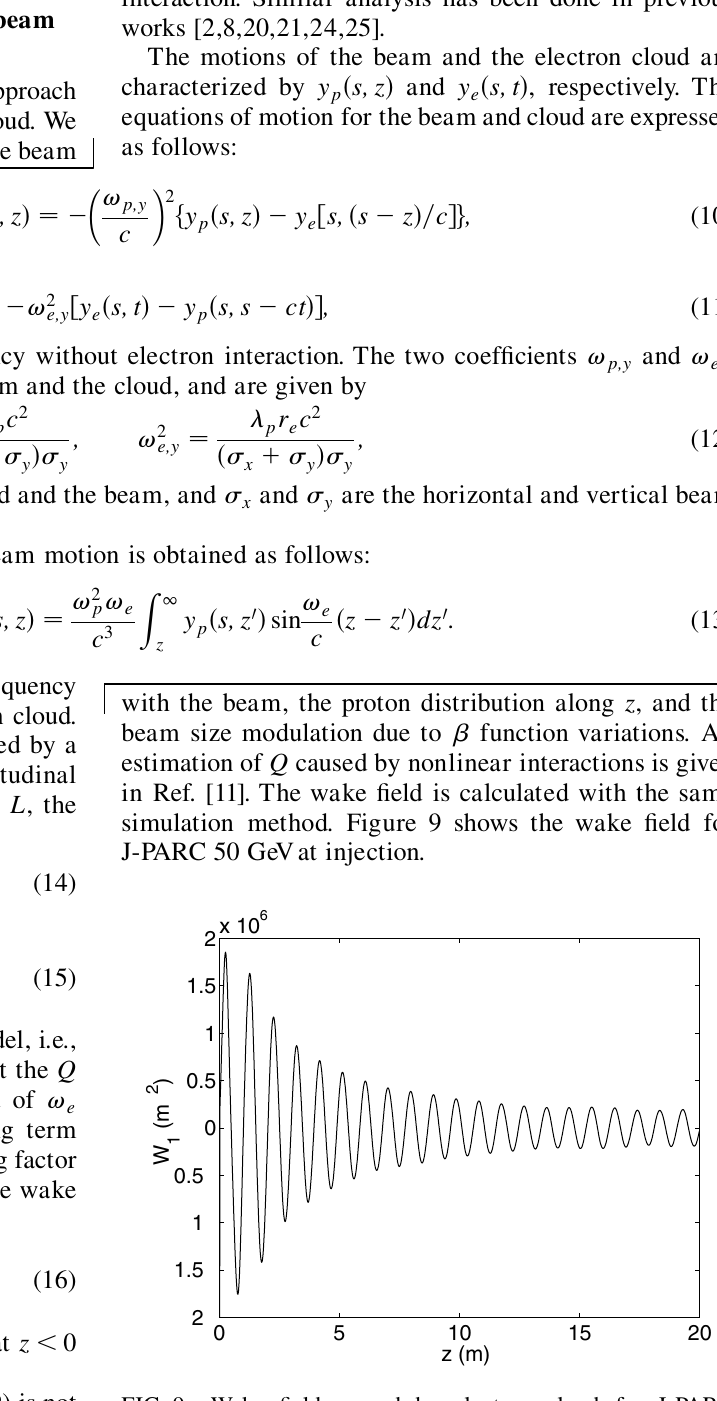
FIG. 9. Wake field caused by electron cloud for J-PARC 50 GeV at